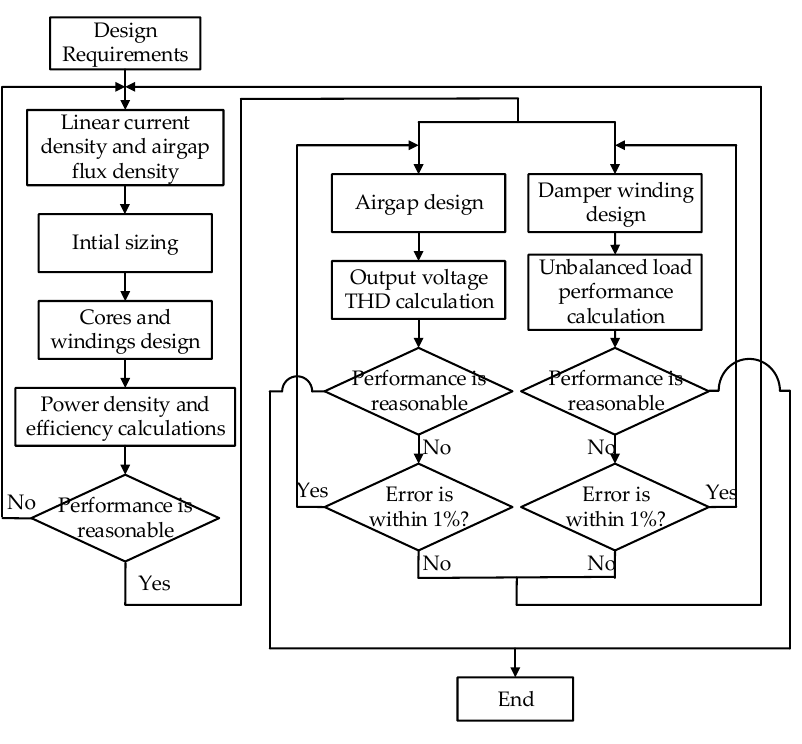
Figure 8. Proposed design method.